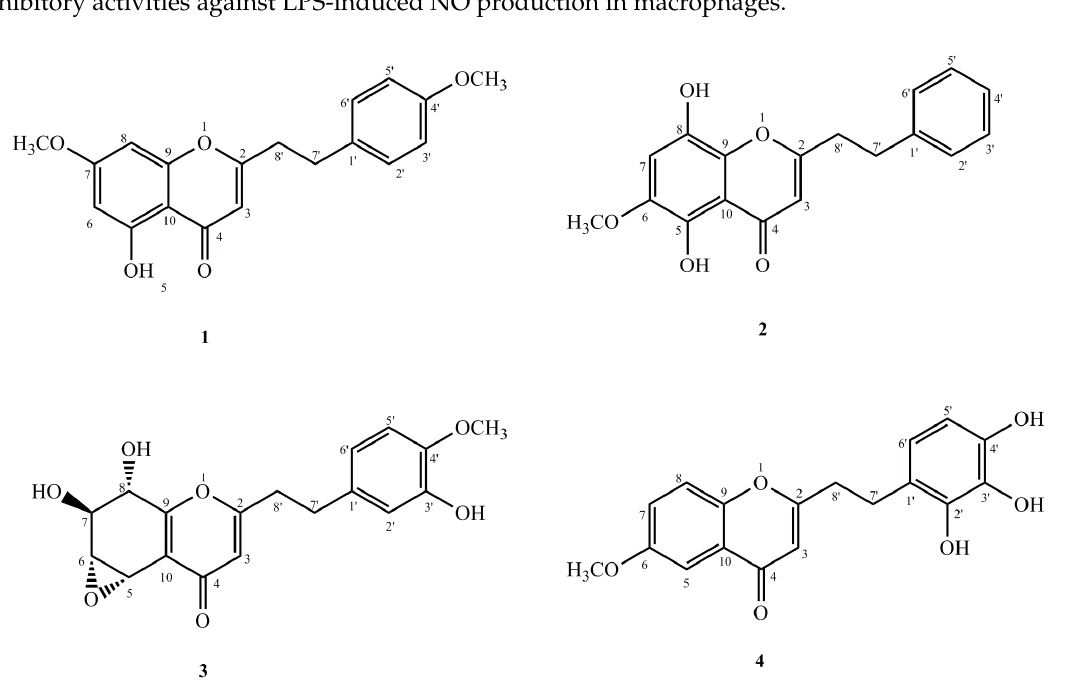
Figure 1. Structures of compounds 1 – 4 .